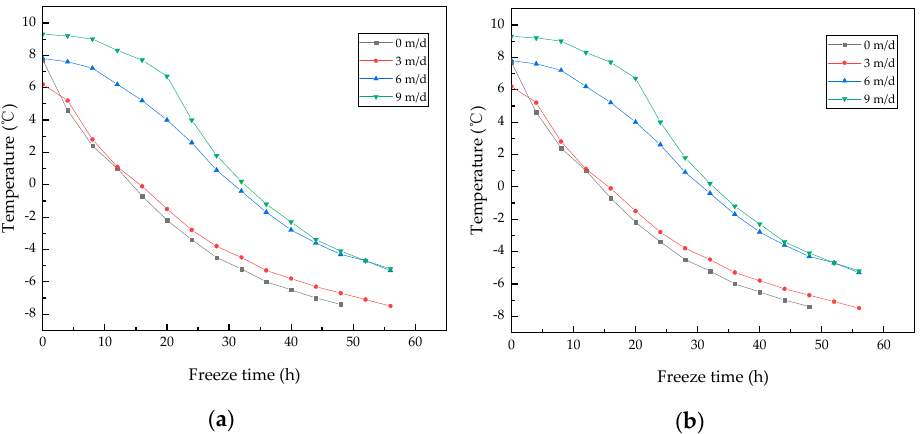
Figure 7. Temperature variation at B3 and B11 under different velocity: ( a ) Temperature variation at B3; ( b ) temperature variation at B11. Figure 7 shows the temperature variations at B3 and B11 with the freezing time for different velocities. Figure 7a shows the temperature reducing curve at B3 for four veloc- ities. As shown in Figure 7a, the temperature at B3 was reduced with the freezing time. At the same freezing time, the larger the velocity, the higher the temperature at B3. Com- pared with the temperature reducing curves at u = 0 m/d and u = 3 m/d, the temperature at B3 at u = 6 m/d and u = 9 m/d began to reduce significantly later, and the temperature developed slowly in the initial stage of freezing. Taking the times from the beginning of the freezing to the temperature at B3 being reduced to 0 °C as an example, the times were 14.4 h, 15.7 h, 30.5 h, and 32.7 h for the four velocities. It can be found that the larger the velocity, the more time it took to reduce the temperature to 0 °C. In this test, in the positive temperature region, the temperature reducing rates at B3 were 0.53 °C/h, 0.39 °C/h, 0.26 °C/h, and 0.27 °C/h for the four velocities. Since the initial temperature of the sand layer at u = 9 m/d was higher than the other three groups of temperatures, it could be considered that the rate of the temperature reduction at B3 in the positive temperature zone decreased with the increase of the velocity. In the negative temperature zone (0 °C to the end of the test), the rate of the temperature reduction at B3 was stable near 0.20 °C/h, and the influ- ence of the velocity was small. Figure 7b shows the temperature reduction curves of B11 with the freezing process for four velocities. It can be seen from the figure that the tem- perature variation change at B11 in the positive temperature zone was rapid when u = 6 m/d and 9 m/d. In the negative temperature zone, the temperature reduction rates at B11 were relatively stable for the four velocities, and the average rate was around 0.18 °C/h. By comparing Figure 7a,b, it can be seen that the temperature in the upstream and downstream of the freezing pipe varied with freezing time. Under the condition of no flow, the temperatures at B3 and B11 had the same law of development, the temperature distribution was symmetrical, and the maximum temperature difference was 0.7 °C. When u = 3 m/d, the maximum temperature difference between B3 and B11 was 1 °C, and the temperature at B11 was lower than that at B3. When u = 6 m/d and 9 m/d, the devel- opments of the temperature at B3 and B11 were obviously different. The temperature at B3 was reduced slowly in the early stage of freezing (positive temperature zone), and the temperature at B11 was reduced rapidly in the early stage of freezing. During the whole freezing process, the temperature at B11 was lower than that at B3. The analysis showed that the effect of the flow caused the difference of the temperature development between upstream and downstream. In the early stage of freezing, the flowing water absorbed the cold energy to reduce the temperature difference in the upstream points, and the low- temperature water after cooling accelerated the development of the temperature in the downstream, which made the downstream temperature develop faster than the upstream